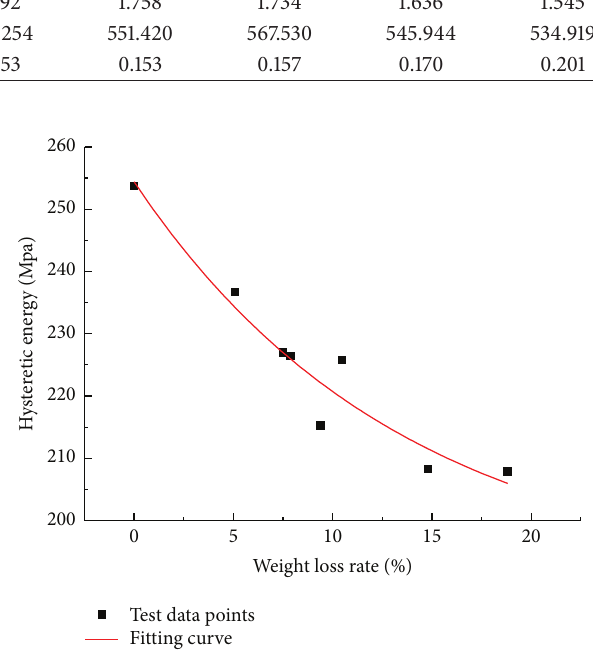
Figure 4: Hysteretic energy change with weight loss